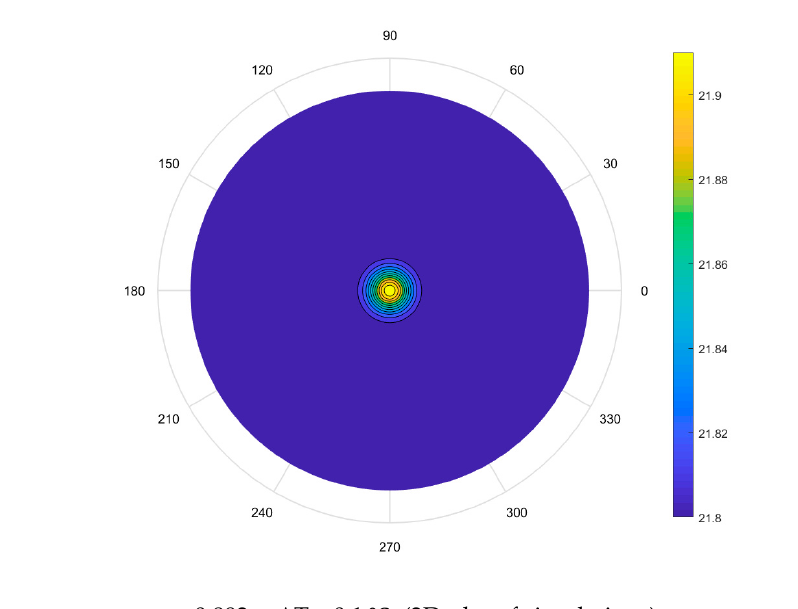
Appl. Sci. 2021 , 11 , x FOR PEER REVIEW 16 of 19